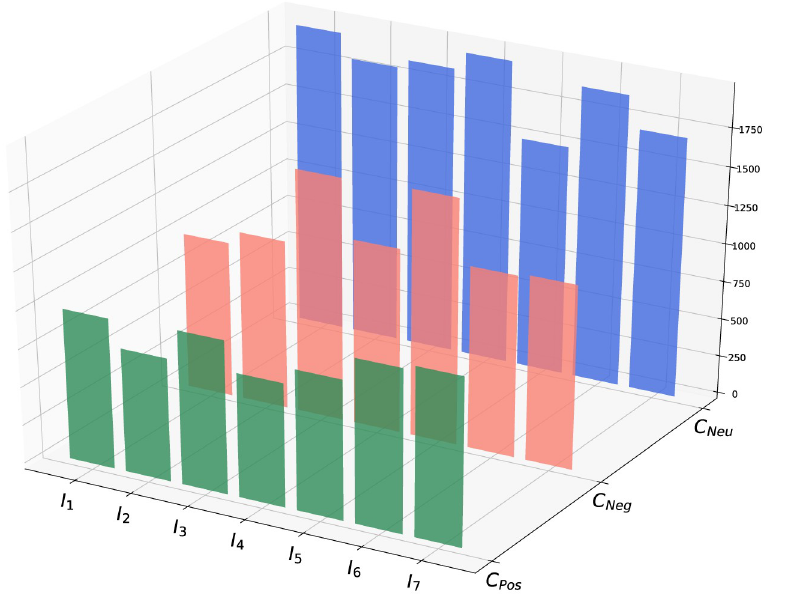
Fig 8. Overall sentimental clusters at different time intervals I m .